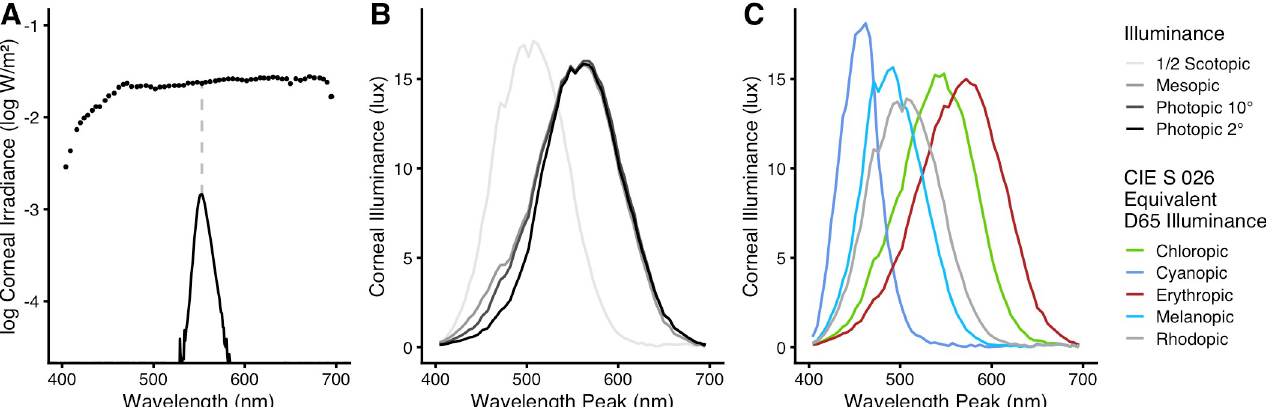
Fig 1. Spectral irradiance measurements and calculated illuminance values at the eye level. All displayed values are based on spectral irradiance measurements with a field-of-view restriction according to the CIE S 026 standard [32]. In our case, these measurements are 24% lower than those of the unobstructed sensor diffusor. Differences in irradiance measurements from the mean were smaller than 5%, or about 1% on the log irradiance scale. Differences in wavelength peak were between 0 to 1 nm. (A) Dots show the log of the corneal irradiance (in log W/m 2 ) of exemplary steps at their respective peak wavelength. Each dot represents a narrowband peak, similar to the spectral example distribution with a peak at 553 nm (the peak is indicated by the gray dashed line). (B) Corneal illuminance values for the narrowband light steps at each peak wavelength. Besides the standard photopic CIE-1931 V( λ ) weighing for the 2˚ observer (black line), illuminance values were calculated based on the weightings of V 10 ( λ ) (10˚ observer, photopic vision, dark grey), of V’( λ ) (scotopic vision, light grey), and of V eq ( λ ) (mesopic vision, medium grey). To show the scotopic illuminance values along with the other curves, they are drawn at half their original value (light-gray curve). (C) Corneal alpha-opic equivalent-daylight illuminance for all receptor types according to the CIE S 026 standard [32].